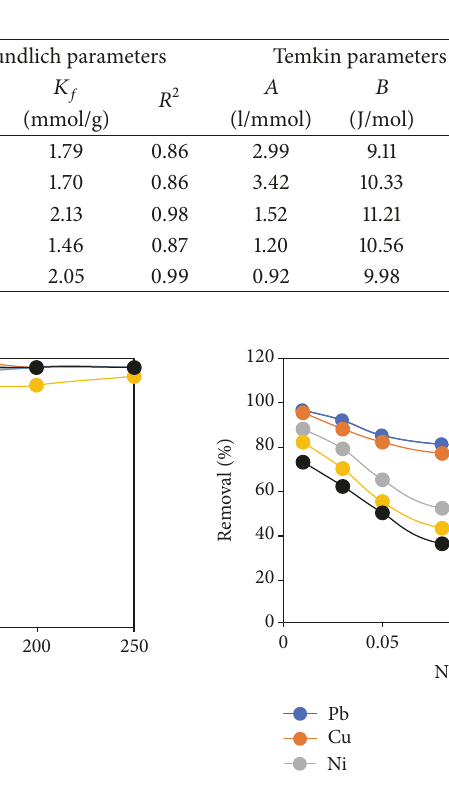
Figure 13: Effect of ionic strength on percentage removal of heavy metal ions by FGCX (conditions: 6 g/l FGCX; pH: Pb = 5, Cu = 5, Ni = 7, Zn = 6, and Cd = 6; contact time: 60min; initial concentration 0.5 mmol/L; temperature: 45 ∘ C; agitation speed: